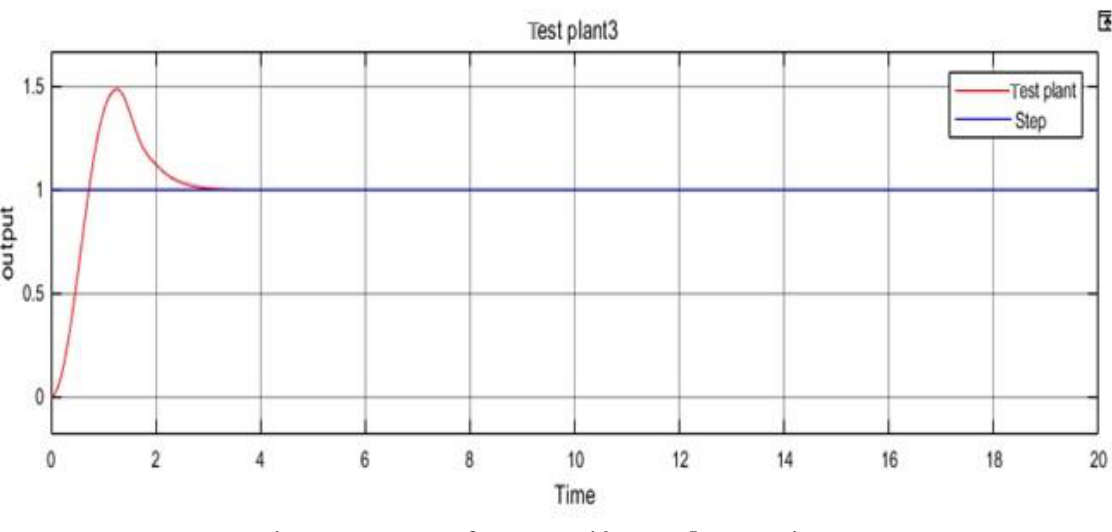
Fig. 8. Response of system with test plant 3 using GA.